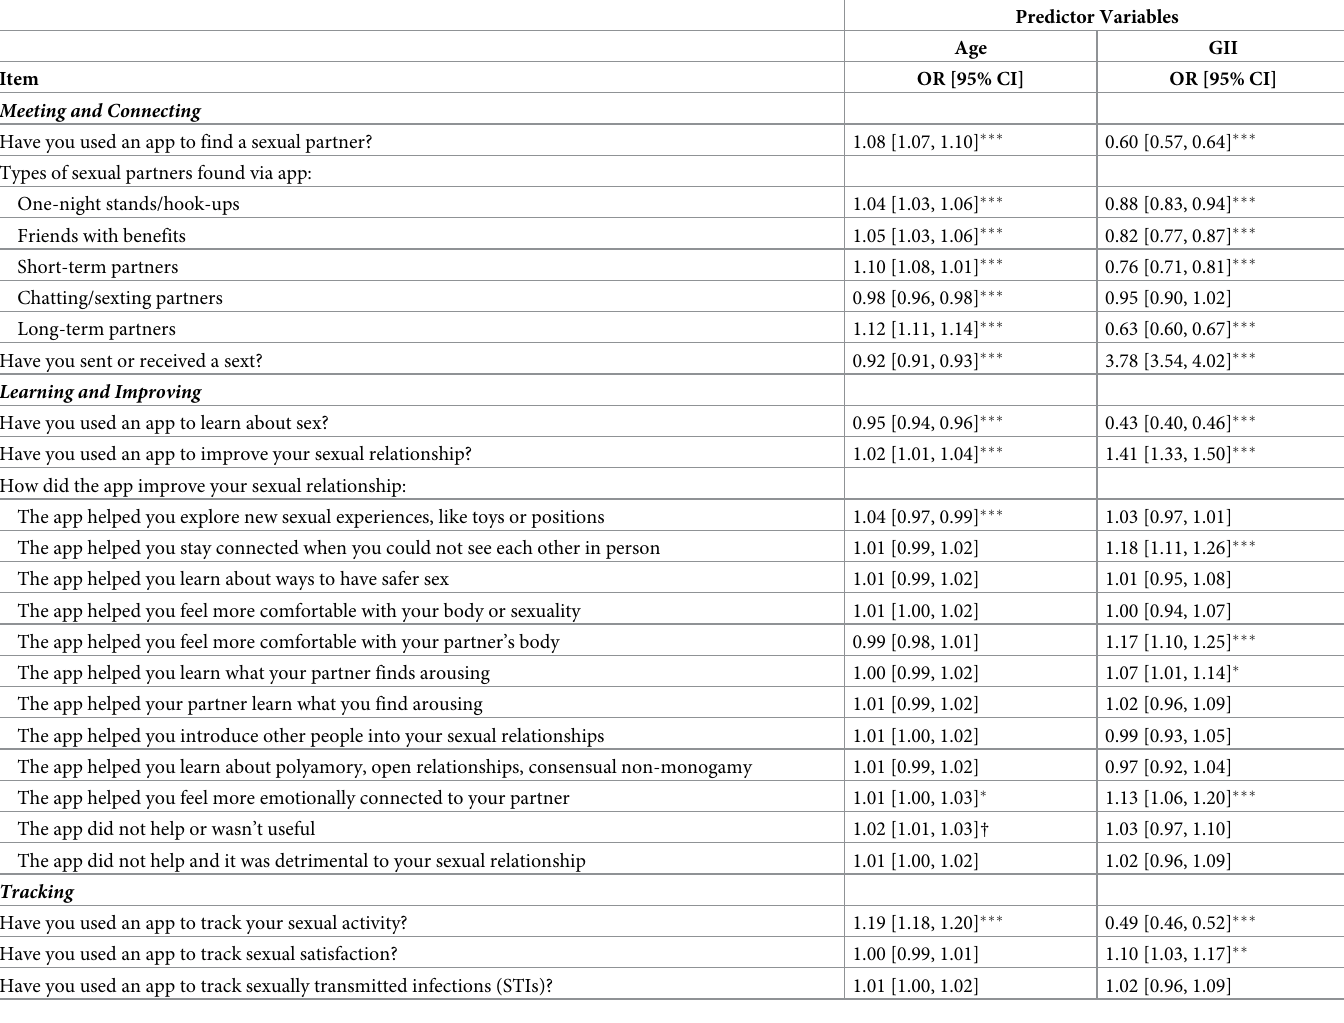
Table 5. Odds ratios and 95% confidence intervals for GII on each sex–tech item, controlling for participant